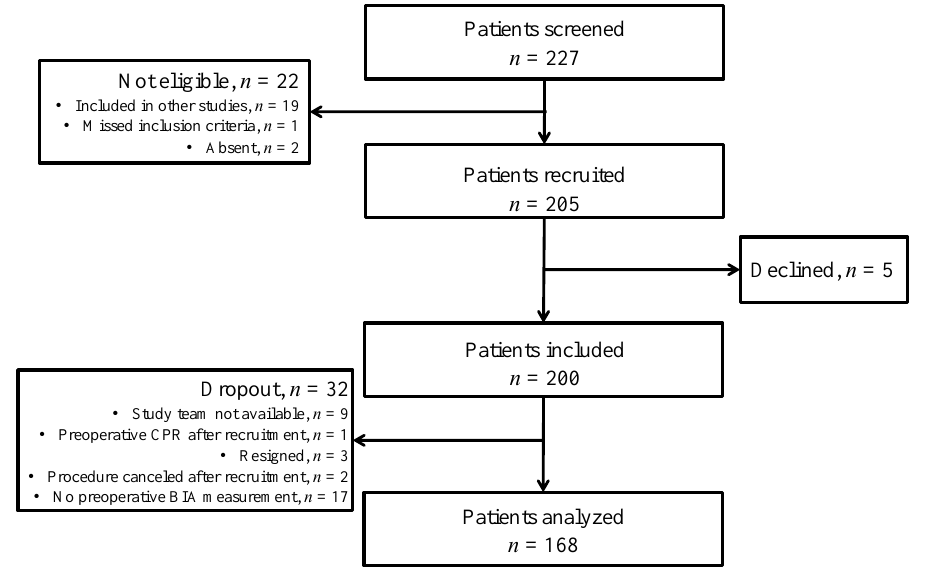
Figure 1. Selection and exclusion criteria for patients enrolled in the study. Table 1. Demographic and surgical characteristics.